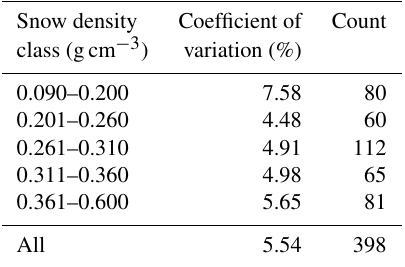
Figure 3. Coefficient of variation of SWE that was measured with three snow samplers according to the period of snow accumulation or melting: the Standard Federal sampler (SFS), the Hydro-Québec sampler (HQS), and the Université Laval sampler (ULS). Boxes represent 25th and 75th percentiles. Bars inform of the lowest and highest quartiles, excluding the outliers represented by the dots. The middle line in each box shows the median of the